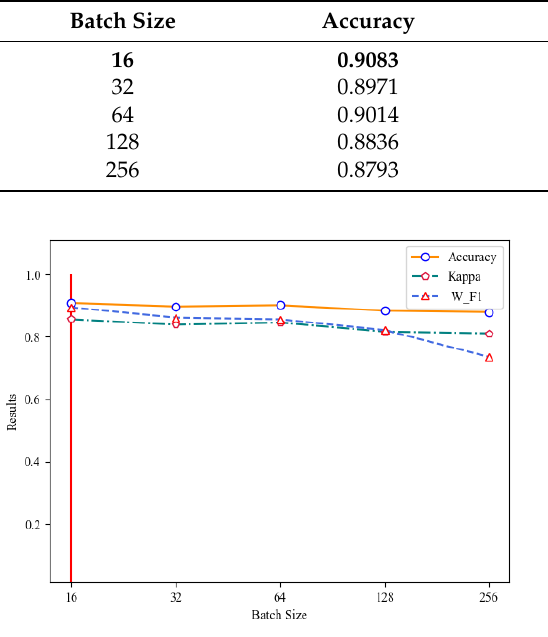
Figure 9. Selection of batch size.